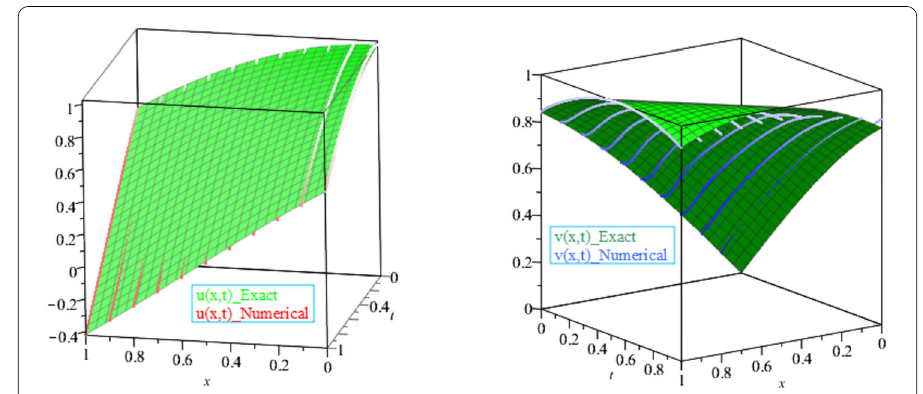
Figure 5 The plots of approximate solutions and exact solutions of u ( x , t ) and v ( x , t ) for Example 5.2 with the noisy data